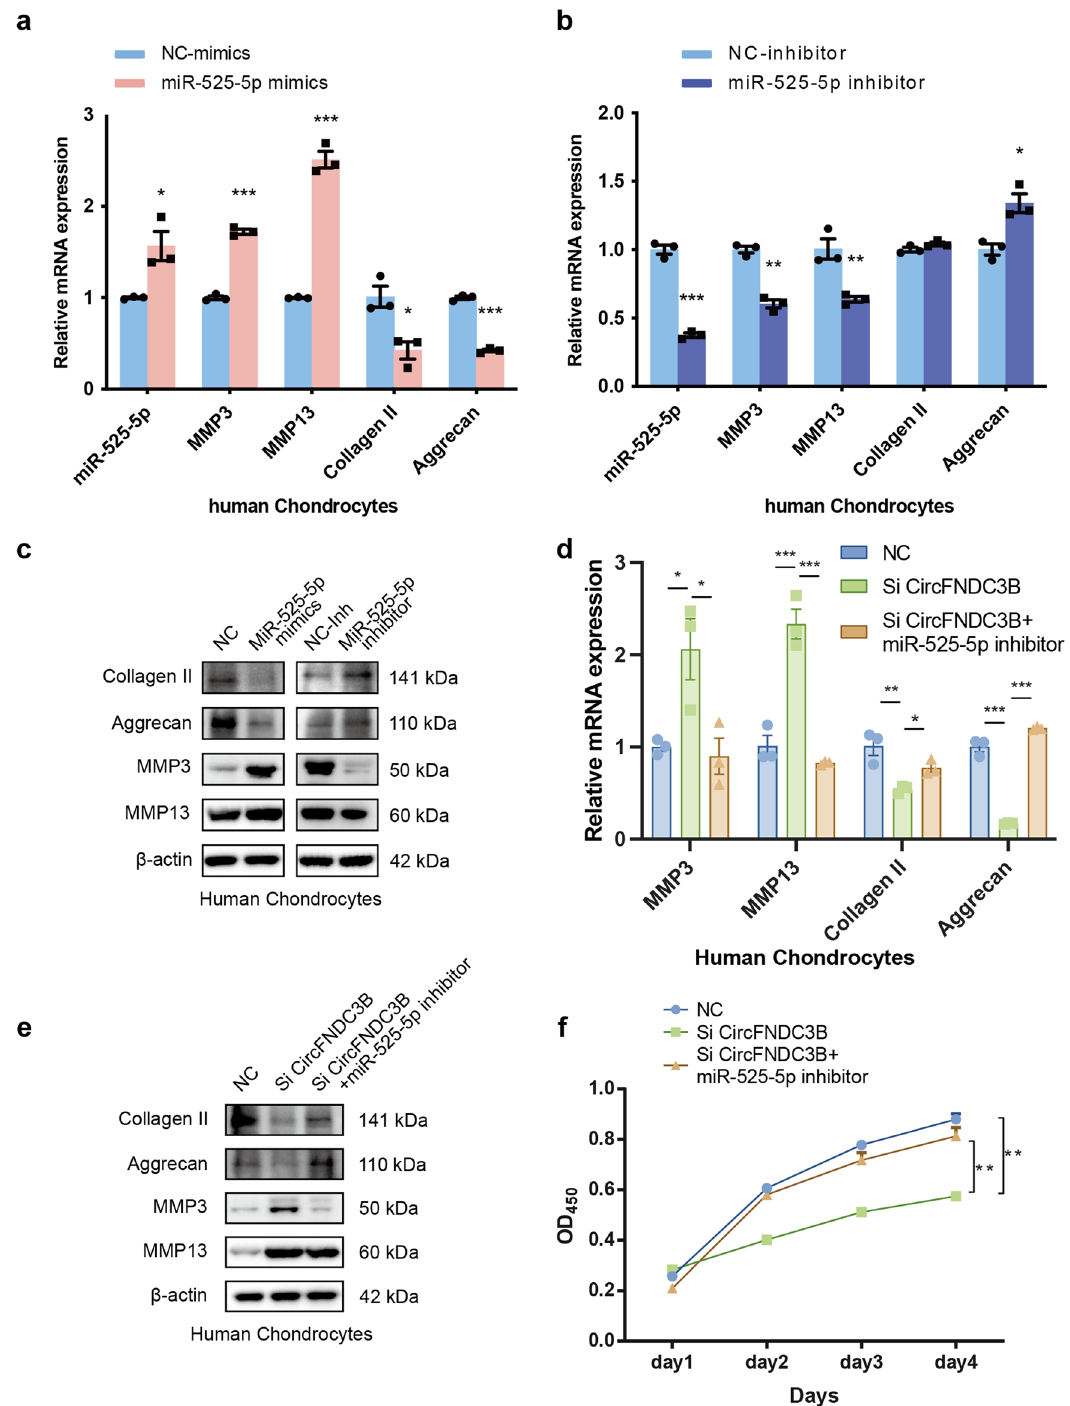
Fig. 5 CircFNDC3B functions by targeting miR-525-5p. a, b RT-qPCR analysis of Collagen II, Aggrecan, MMP3, and MMP13 when HCs were overexpression or knockdown of miR-525-5p. ( n = 3). * p < 0.05, ** p < 0.01, *** p < 0.001 by Student ’ s t test. c Western blot analysis of Collagen II, Aggrecan, MMP3, and MMP13 when HCs were overexpression or knockdown of miR-525-5p. d – f RT-PCR, western blot and CCK-8 assay showed that the downregulation of miR-525-5p antagonized the effect of si-CircFNDC3B on Collagen II, Aggrecan, MMP3, and MMP13 in HCs. ( n = 3). RT-PCR results: * p < 0.05, ** p < 0.01, *** p < 0.001 by Student ’ s t test. CCK-8 assay results: ** p < 0.01 by